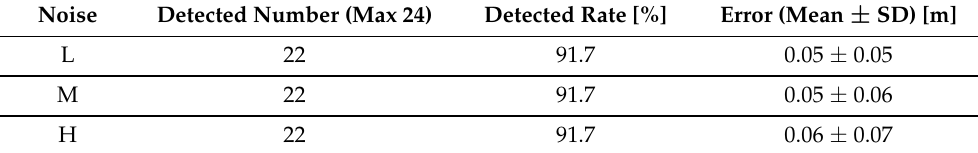
Table 5. Results of leakage position estimations with three crowded waterdrops